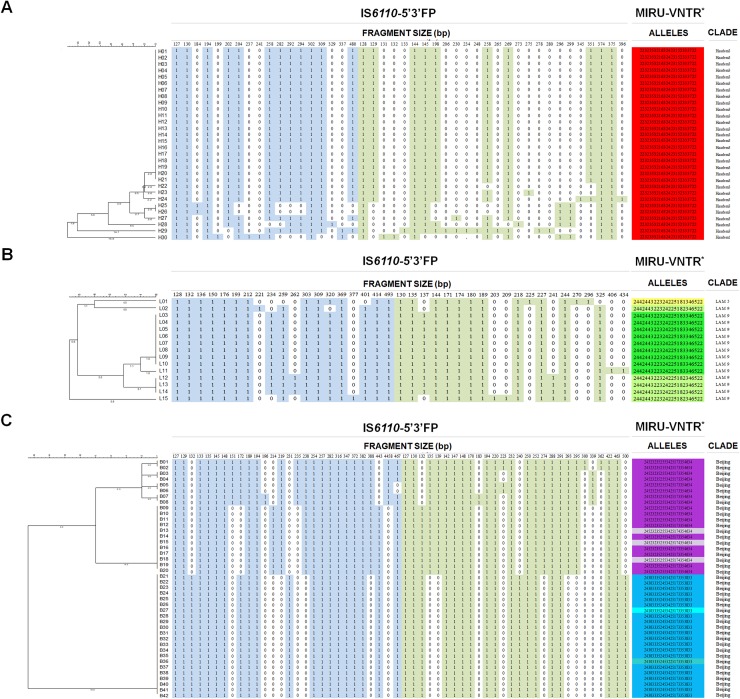
Assessment of the discriminatory power of IS6110-5’3’FP and 24-loci MIRU-VNTR.M. tuberculosis strain collections belonging to Haarlem (A), LAM (B), and Beijing (C) genotypes were used.